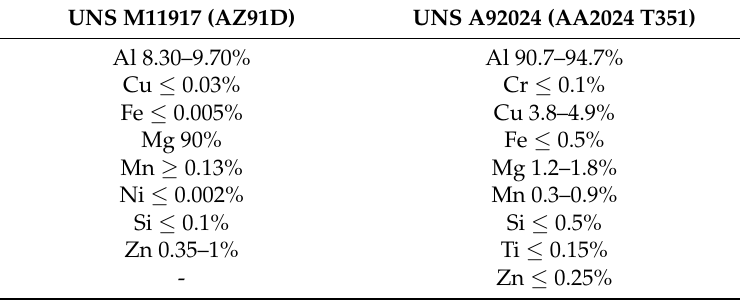
Table 3. Chemical composition of materials used for the manufacturing specimens.